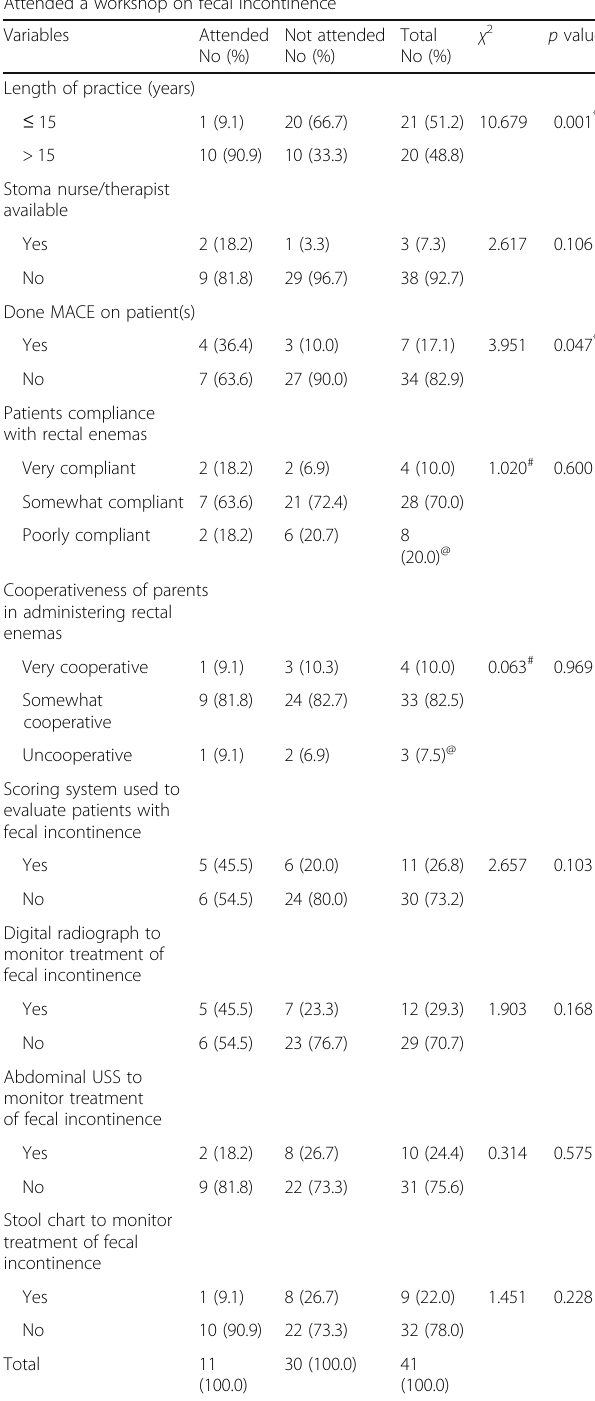
Table 1 Association between experience, practices concerning fecal incontinence, and previous attendance of workshop Attended a workshop on fecal incontinence